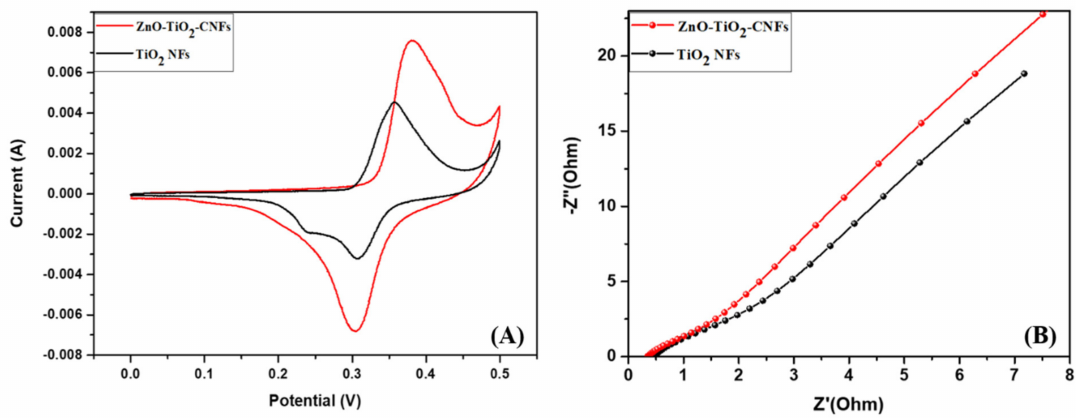
Figure 8. Cyclic voltammetry (CV) curves at the scan rate of 10 mV / s ( A ) and EIS spectra ( B ) of ZnO-TiO 2 -CNFs composite as compared to TiO 2 NFs.